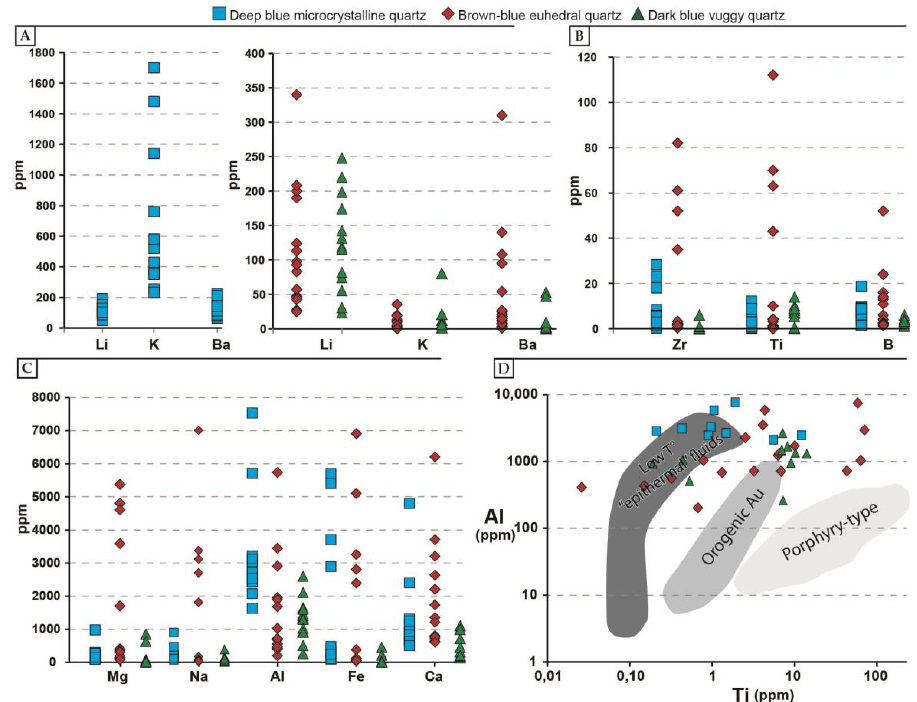
Figure 9. Concentration of trace elements measured in quartz through LA-ICP-MS, for main quartz generations: ( A ) Li, K, and Ba; ( B ) Zr, Ti, and B; ( C ) Mg, Na, Al, Fe, and Ca; and ( D ) Al vs. Ti concentrations of main quartz generation. Zones correspond to values of hydrothermal quartz from low T°C, orogenic Au, and porphyry-type deposits